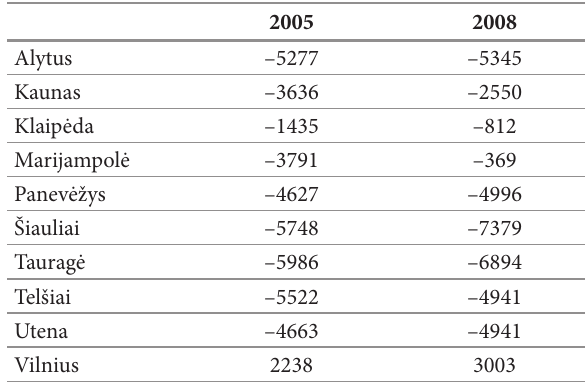
Table 7. Migration flows per Lithuanian